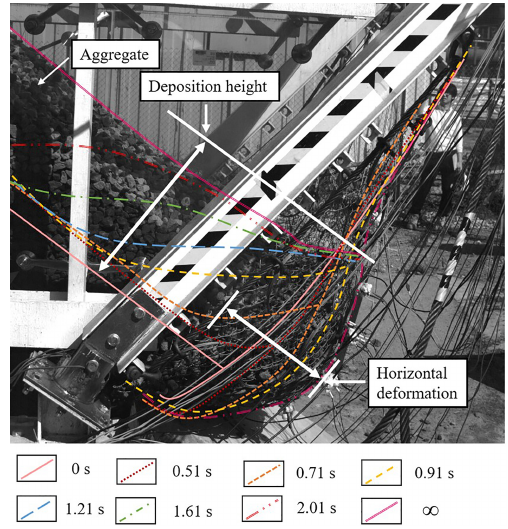
Figure 5. Side profiles of deposited aggregate at different times in test